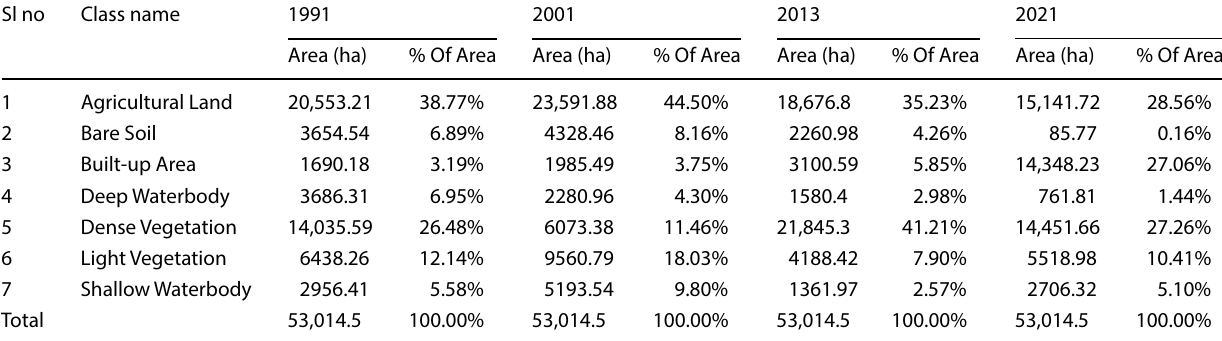
Table 3 Area statistics of land use classes of Jamalpur for the years 2001, 2013 and 2021 Sl no